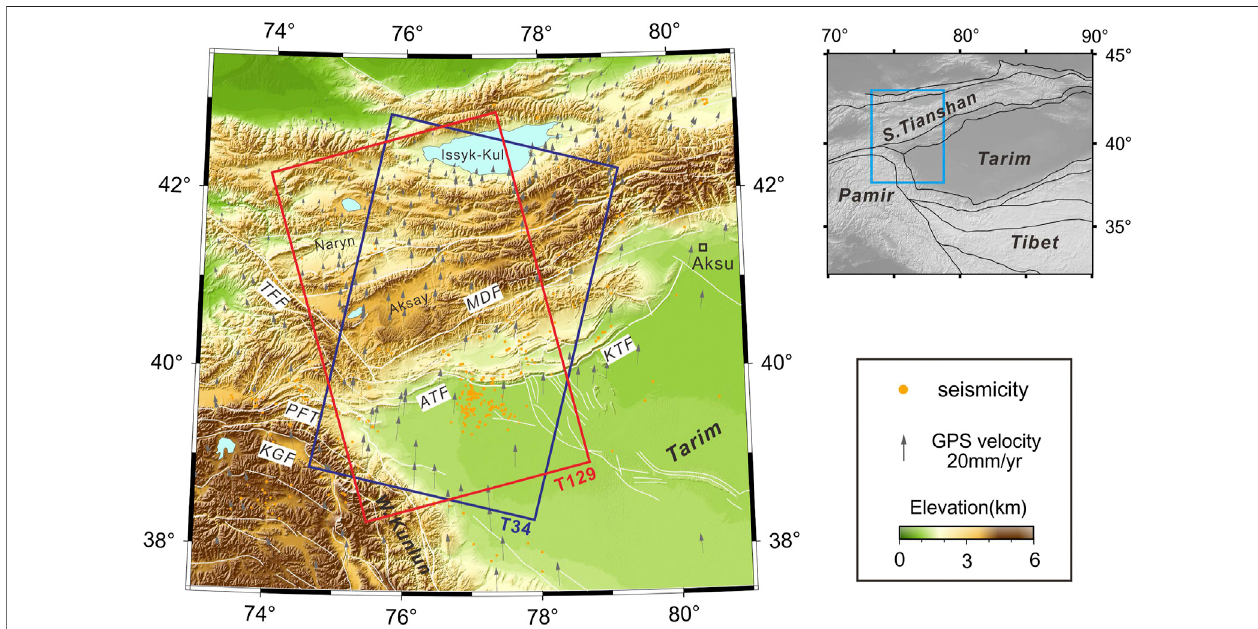
FIGURE1| Topographic and tectonic map of the study area superimposed on Digital Elevation Model of the Shuttle Radar Topography Mission (SRTM DEM). Gray vectors represent the GPS velocities with respect to stable Eurasia plate (Wang and Shen, 2020). White lines represent fault traces from http://www. activefault-datacenter.cn. Orange dots are the locations of M > 4.5 earthquakes since 1992. Blue and red rectangles delimit the extents of Sentinel-1A/B radar imagery on ascending (129) and descending tracks (34). ATF: Atushi fault, MDF: Maidan fault, KTF: kepingtag fault, KGF: Kongur fault, PFT: Pamir front thrust, TFF: Taras-Fergana